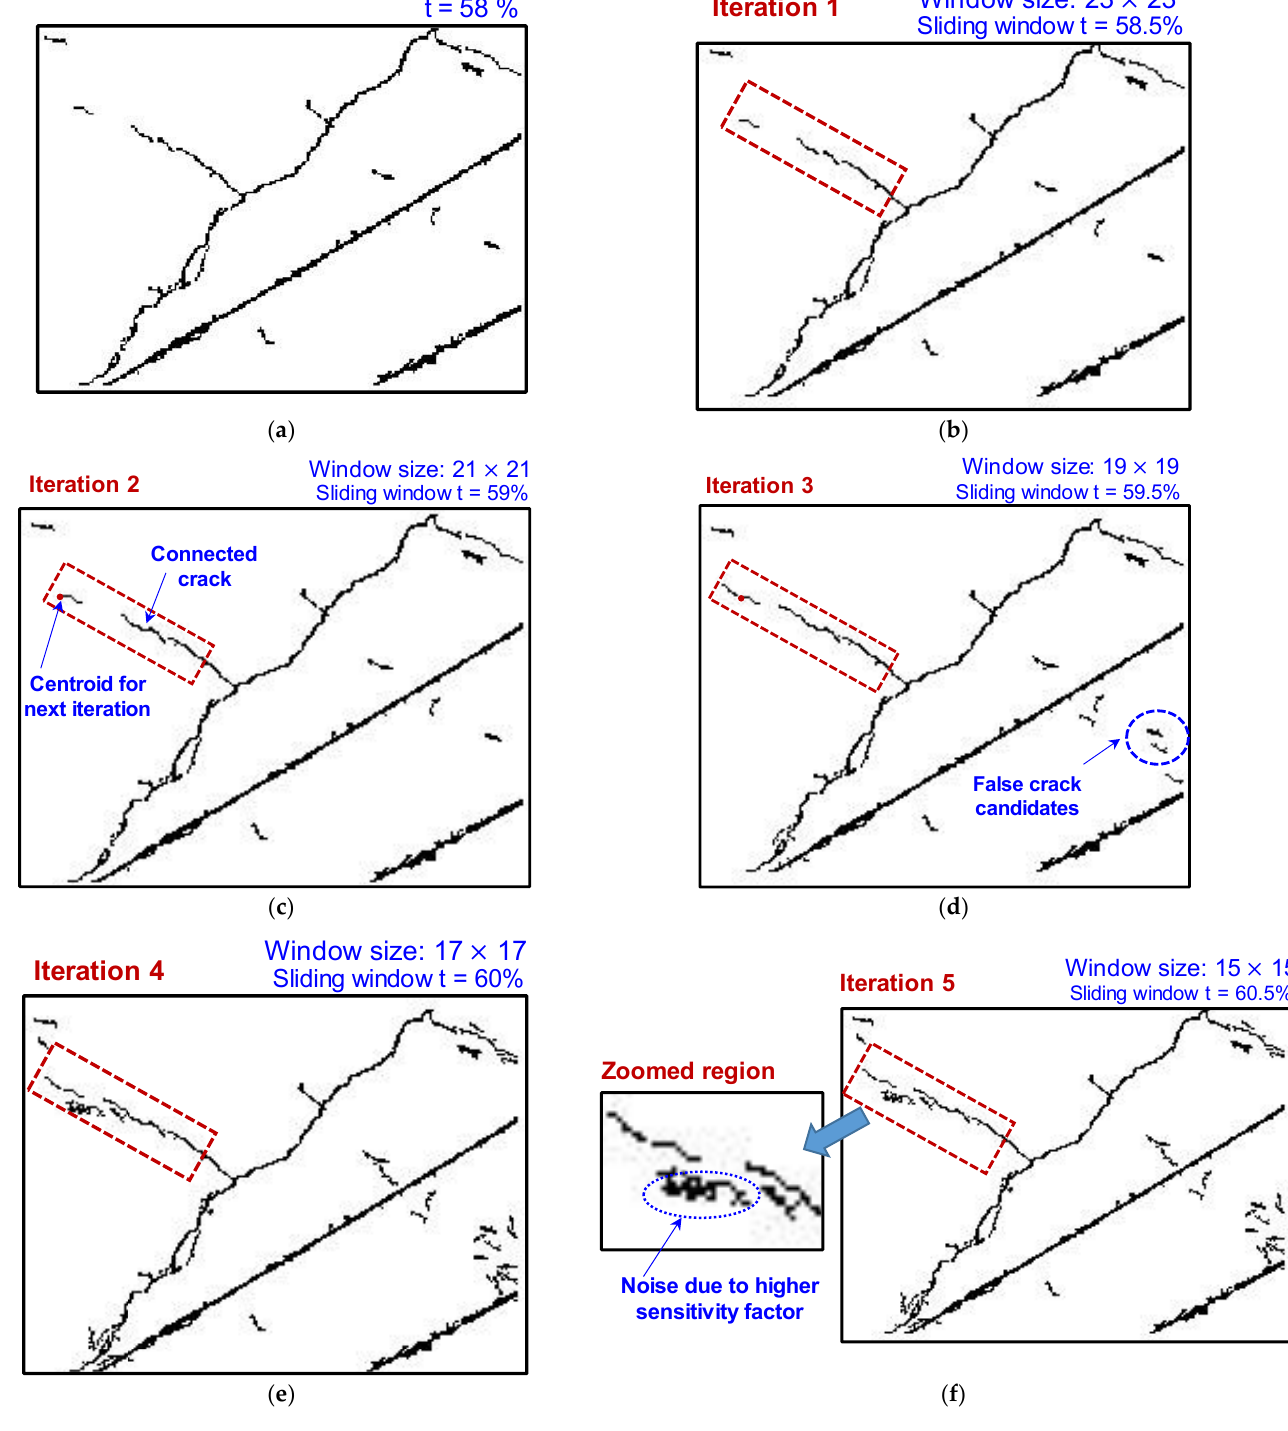
Figure 7. Results for identification of thin shallow cracks of single-pixel width. ( a ) Crack feature identification using 1D DL model. ( b – f ) Iteratively tracking missing segments of thin cracks (see ( b )) post DL using a differential sliding window with increasing threshold.